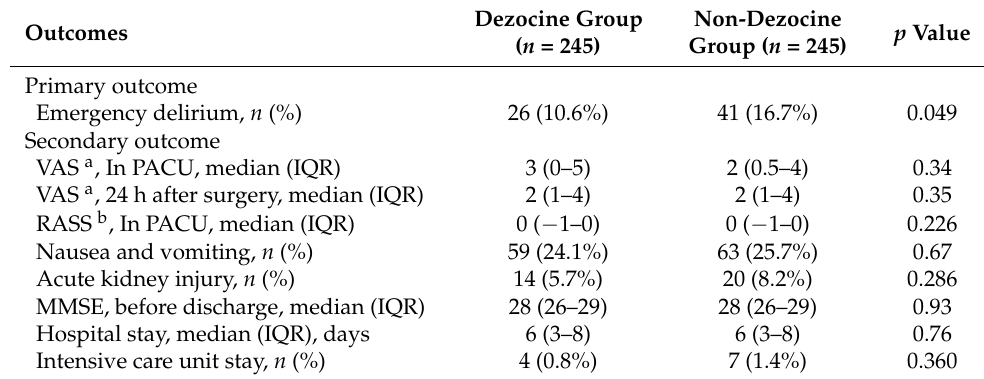
Table 4. Outcomes in the propensity score—matched